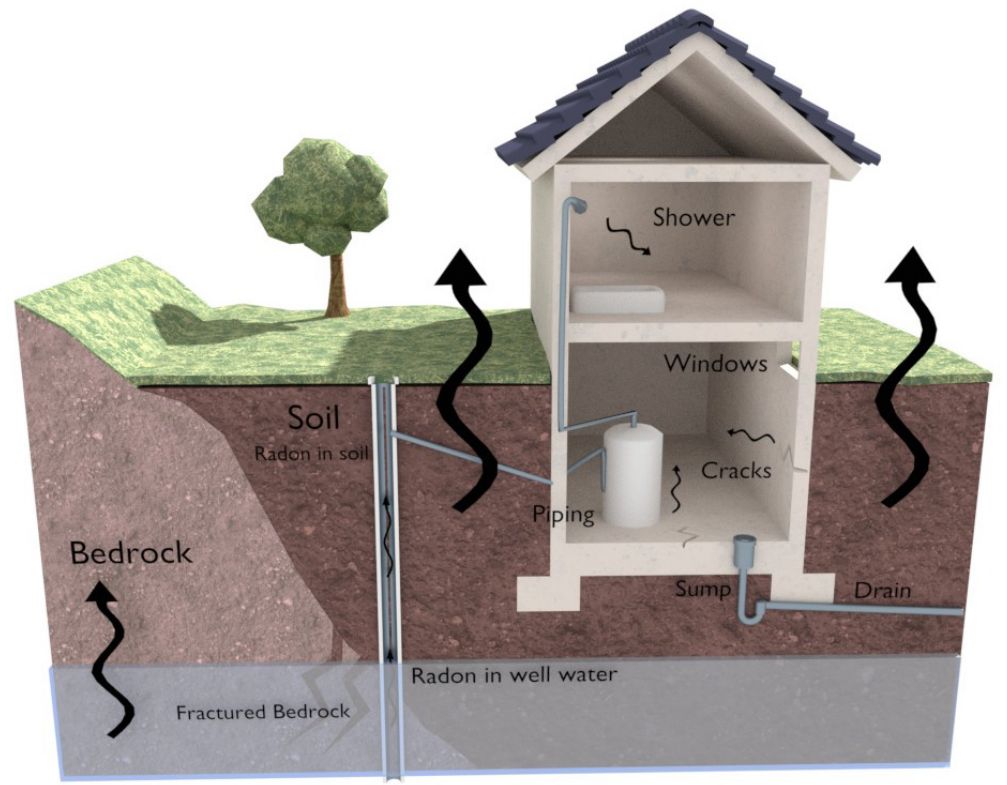
Figure 1. Possible radon entry points in a